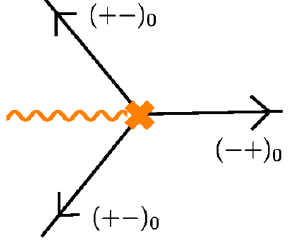
Figure 13. Local structure of BPS trajectories near a + (cid:0) branch